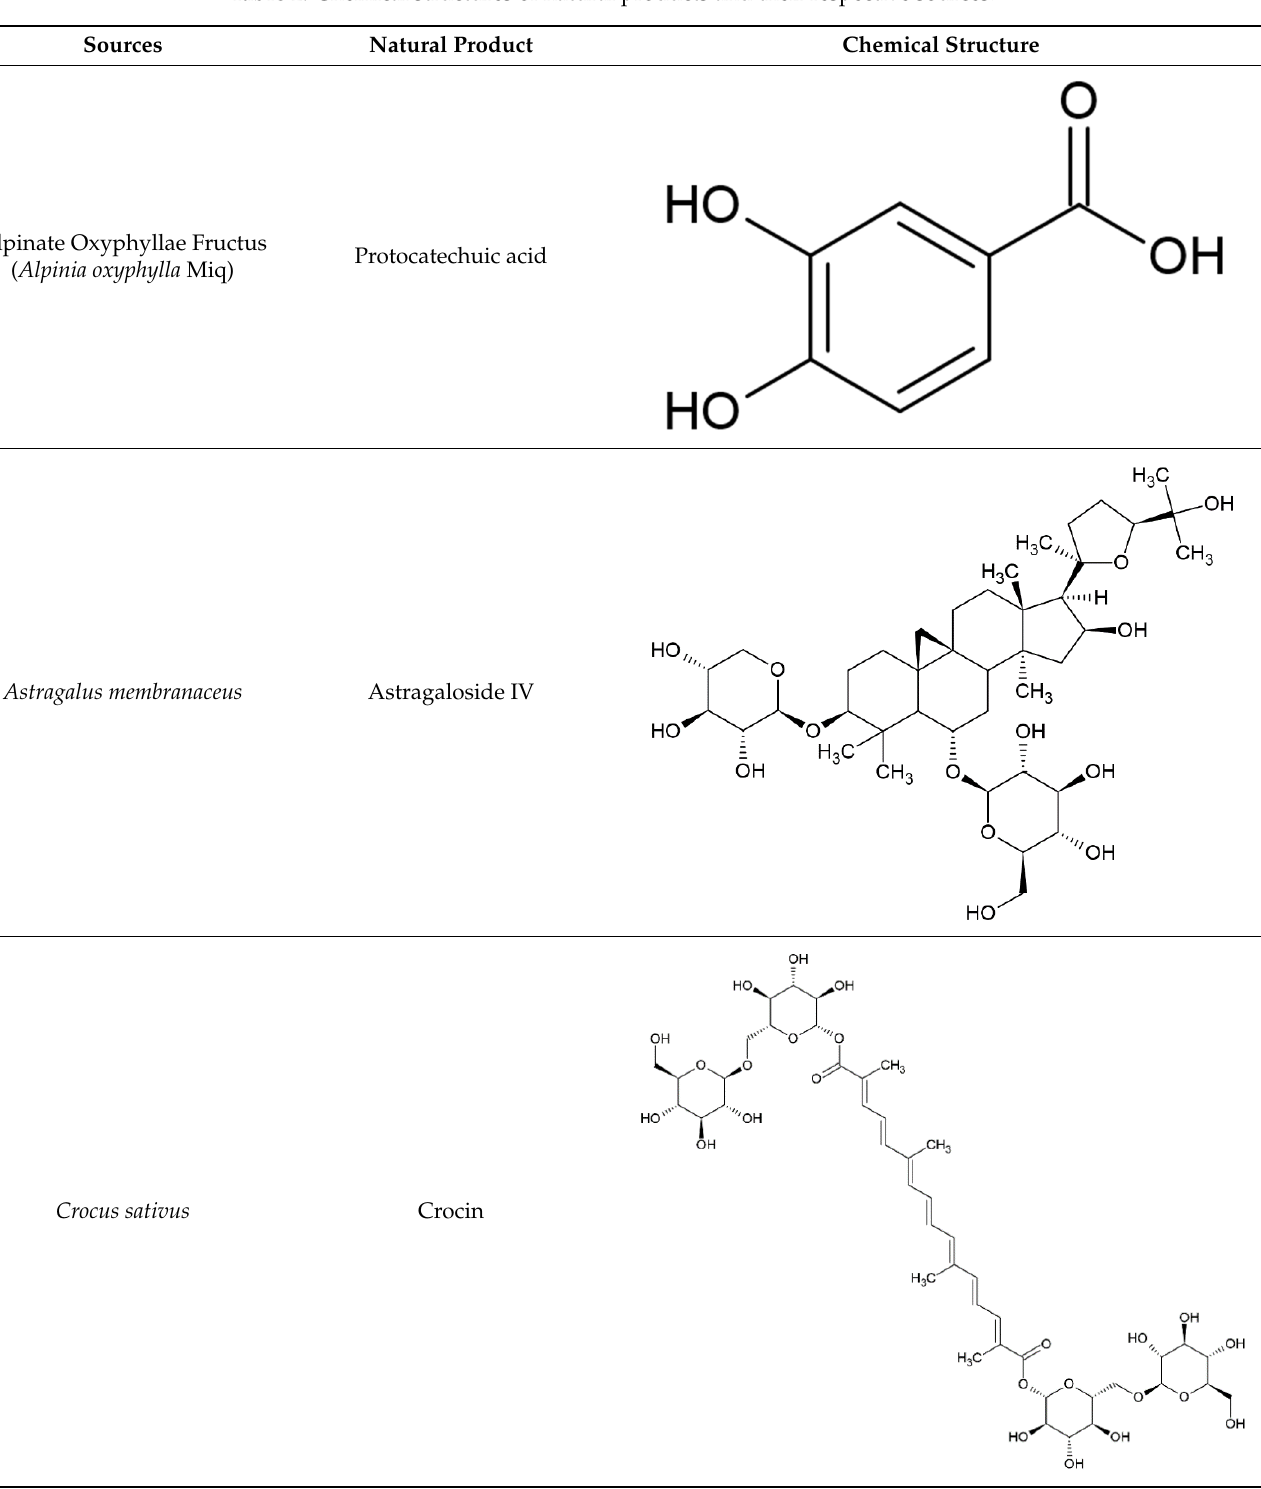
Table 2. Chemical structures of natural products and their respective sources.